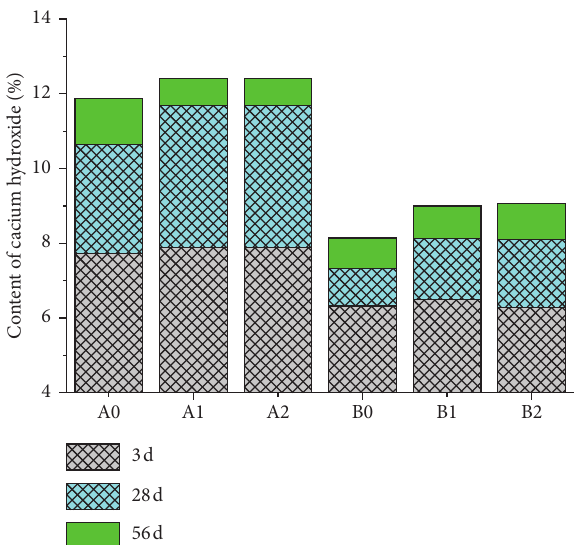
Figure 9: Effect of IC with SAP on calcium hydroxide in harden cement pastes. (A) Cement pastes without FA; (B) cement pastes with FA.